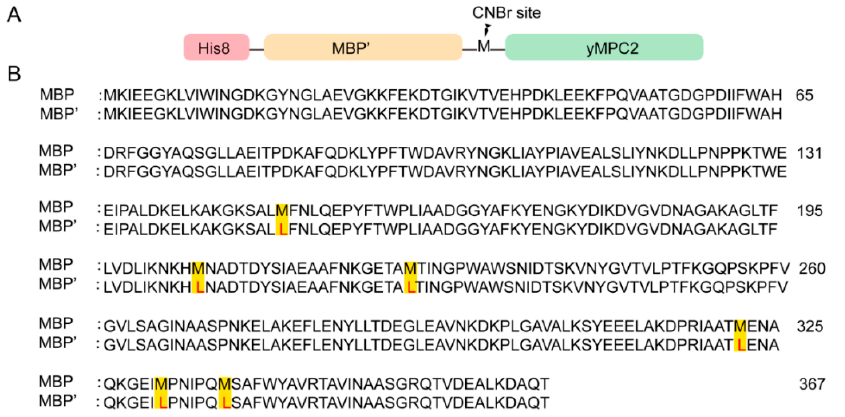
Figure 1. Construct of yMPC2 and the modified MBP tag. ( A ) A linear overview of the domain organization of yMPC2 construct used in this paper. ( B ) Amino acid sequence of MBP tag (residues 27–392) with the methionine residues (highlighted in yellow) mutated to leucine (red), named MBP ′ . The yMPC2 was purified using a totally different protocol from yMPC1 (Figure S3). The His8-MBP ′ -yMPC2 inclusion bodies were denatured in Dissolving Buffer B (100 mM NaCl, 0.5 mM β -ME, 6 M GuHCl, 50 mM Tris-HCl pH 8.0) and loaded onto a Ni-NTA column, and then eluted by imidazole. The eluted His8-MBP ′ -yMPC2 was dialyzed to remove the denaturant GuHCl, and then protein precipitants were dissolved in 80% formic acid (FA) and cleaved by CNBr (Figure 2A). After removing FA and CNBr by dialysis, the protein mixtures were lyophilized and dissolved again in Dissolving Buffer B. A second Ni affinity chromatography was performed to remove the His8-MBP ′ tag and the un- cleaved fusion proteins (Figure 2B). The flow through, mainly containing yMPC2, was collected and reconstituted by adding a sufficient amount of DPC and dialyzing in Buffer D (100 mM NaCl, 50 mM MES pH 6.5). The yMPC2 protein was further purified by SEC using a HiLoad 6/16 pg Superdex 200 column, showing a single sharp peak at 82.5 mL (Figure 2C). The pure fractions from SEC were collected and verified by SDS-PAGE and mass spectrometry (Figure 2D,E), showing that 14 N-yMPC2 is a homogeneous monomer with MW of 14,352.74, which is consistent with the theoretical MW 14,357.49. A typical yield for yMPC2 production is ~3 mg/L.